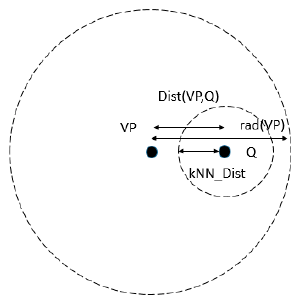
Figure 7. Pruning the right subtree.